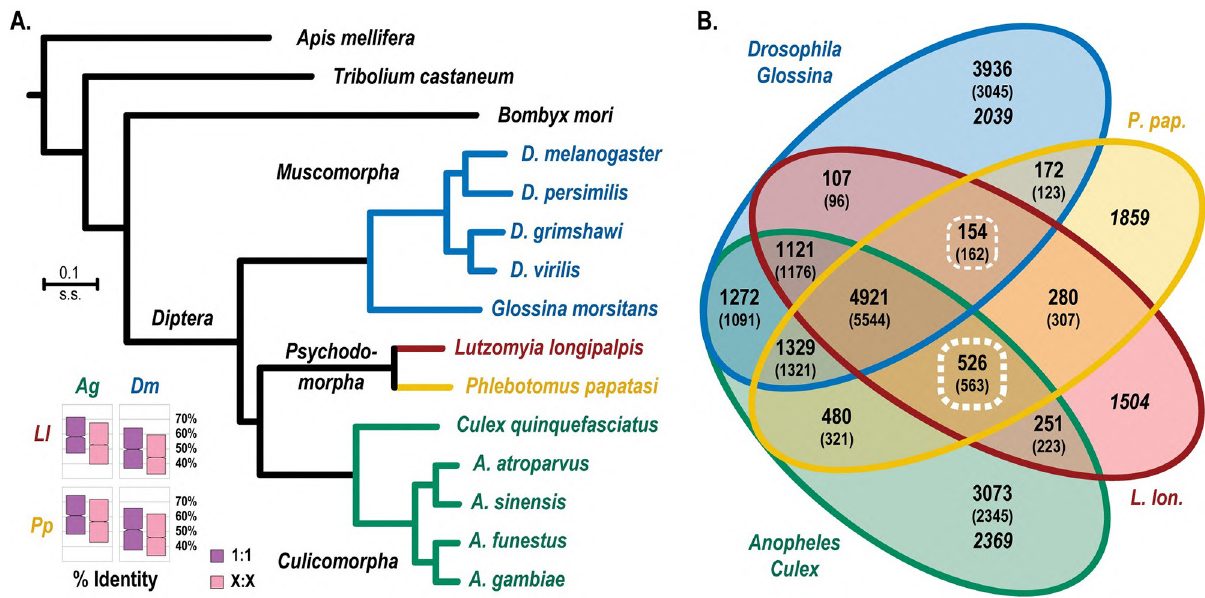
Fig 2. Molecular species phylogeny and ortholog sharing. (A) The quantitative maximum likelihood species phylogeny computed from the concatenated superalignment of 1,627 orthologous protein-coding genes places the sand flies (Psychodomorpha) as a sister group to the mosquitoes (Culicomorpha) rather than the flies (Muscomorpha), with all branches showing 100% bootstrap support. The Culicomorpha are represented by four Anopheles mosquito species and Culex quinquefasciatus and the Muscomorpha include four Drosophila fruit fly species and the tsetse fly, G . morsitans . Outgroup species represent Lepidoptera ( Bombyx mori ), Coleoptera ( T . castaneum ), Hymenoptera ( Apis mellifera ), and the phylogeny is rooted with the phthirapteran human body louse, Pe . humanus . The inset boxplots show that single-copy (1:1) and multi-copy (X:X) ortholog amino acid percent identity is higher between each sand fly (Ll, Lu . longipalpis ; Pp, Ph . papatasi ) and An . gambiae (Ag) than D . melanogaster (Dm). Boxplots show median values with boxes extending to the first and third quartiles of the distributions. (B) The Venn diagram summarizes the numbers of orthologous groups and mean number of genes per species (in parentheses) shared among the two sand flies (L. lon., Lu . longipalpis ; P. pap., Ph . papatasi ) and/or the Culicomorpha and/or the Muscomorpha. Analysis of ortholog sharing shows that the sand flies share more than three times as many orthologous groups exclusively with the Culicomorpha ( Anopheles and Culex ) compared to the Muscomorpha ( Drosophila , Glossina ) (subsets highlighted with thin and thick dashed lines). Numbers of unique genes are in italics. Colors in panel A and panel B match species and sets of species analyzed.